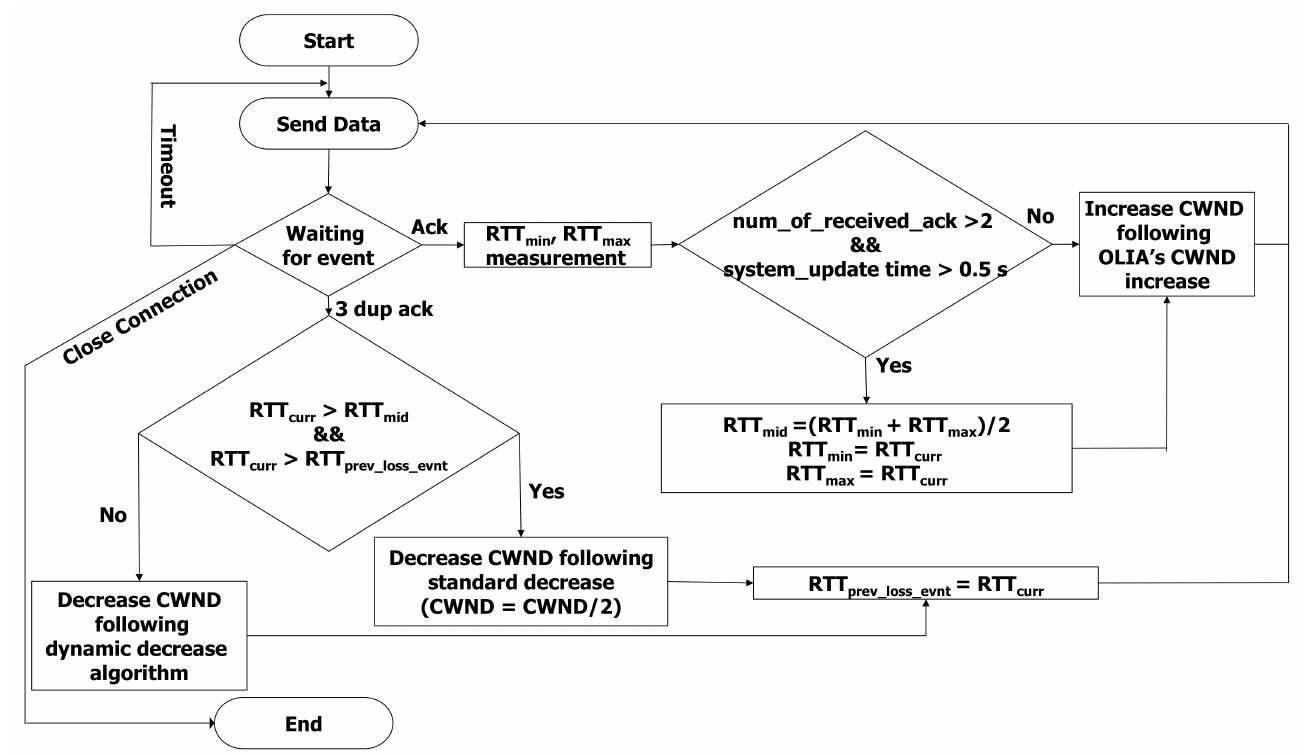
Figure 2. Flowchart of per-flow CWND adjustment process of the proposed D-OLIA